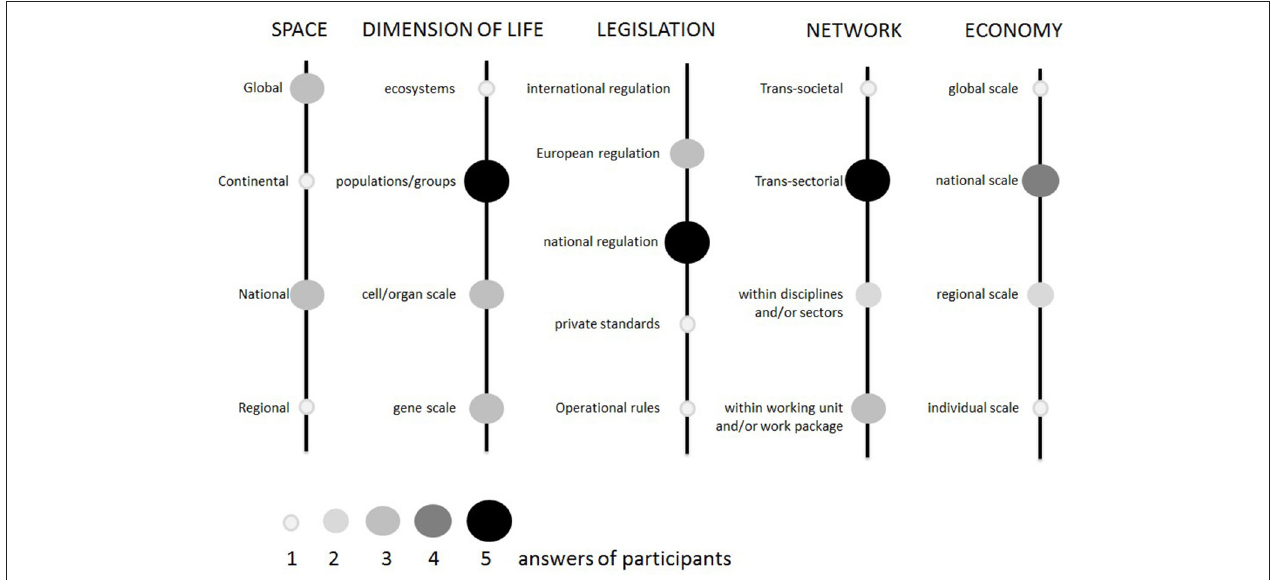
FIGURE 2 | Answers from eight stakeholders and external partners to the online question, “how are the following dimensions (or aspects) reflected in the UC-CARE project outcomes? (Or how comprehensive is the project with regard to these dimensions of One Health?)”.